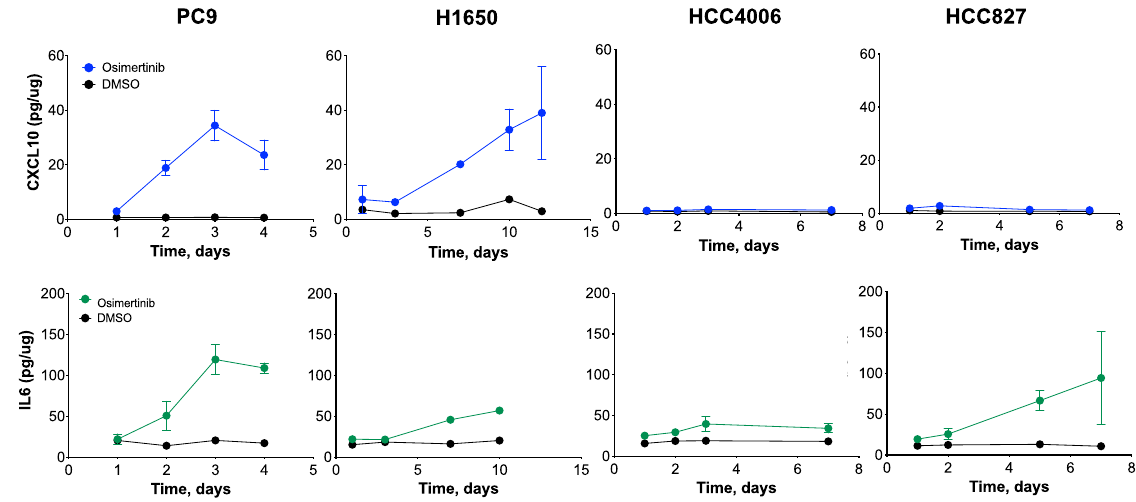
Fig. 2 Distinct patterns of CXCL10 and IL6 induction in EGFR mutant lung cancer cell lines treated with osimertinib. Media from PC9, H1650, HCC4006, and HCC827 cells treated with 300 nM osimertinib or DMSO control for the indicated time points was collected and submitted to ELISA measurements of CXCL10 and IL6 protein. The data are the mean and SEM of three independent